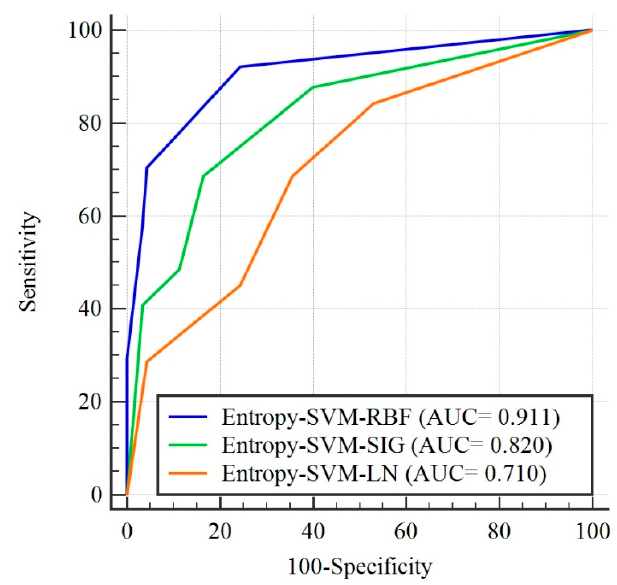
Figure 7. Evaluation the accuracies of the models’ karst groundwater potential mapping using the ROC curve. ROC Table 4. Statistical metrics used to evaluate the models’ performances.